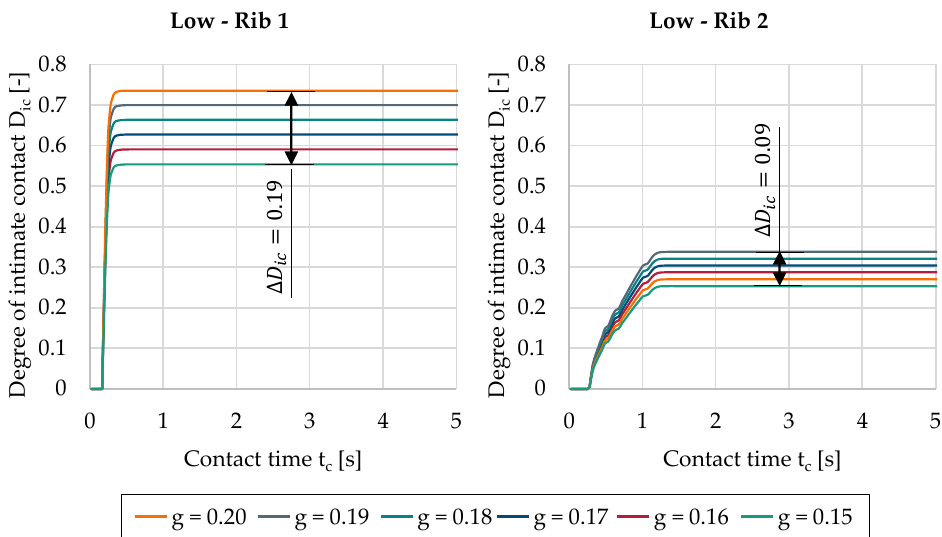
Figure 11. Influence of the geometry factor on the degree of intimate contact exemplary shown for the first and second rib of the lowest process parameter (“Low”).